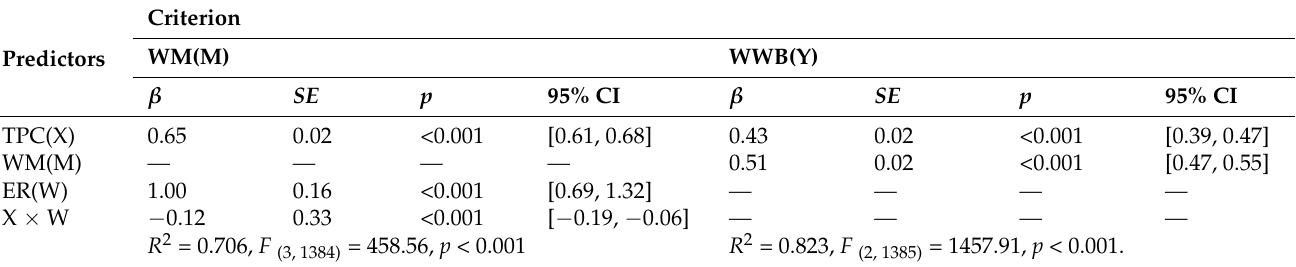
Table 4. Testing the pathways of the moderated mediation